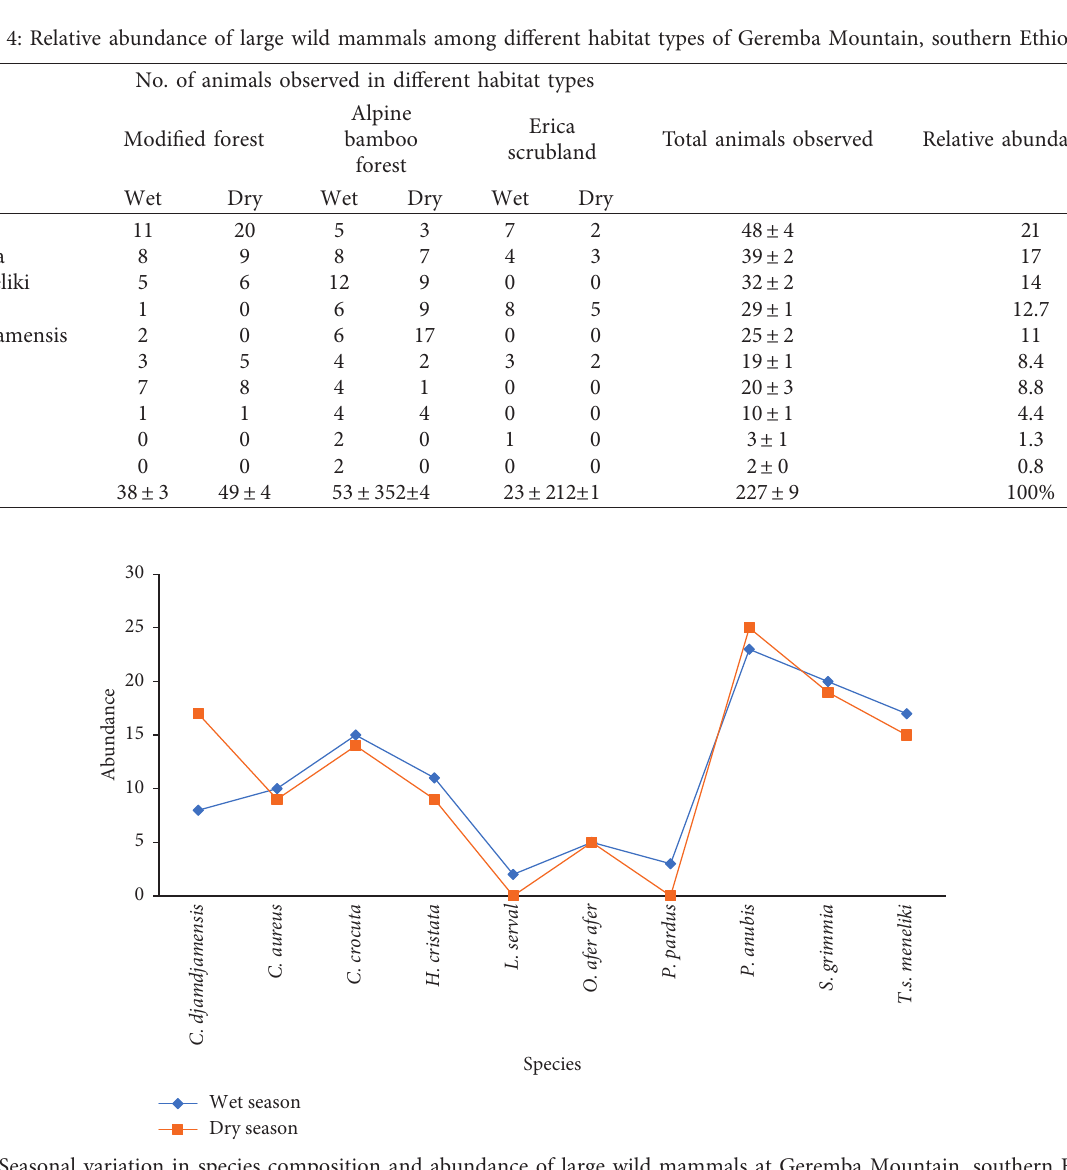
Figure 7: Seasonal variation in species composition and abundance of large wild mammals at Geremba Mountain, southern